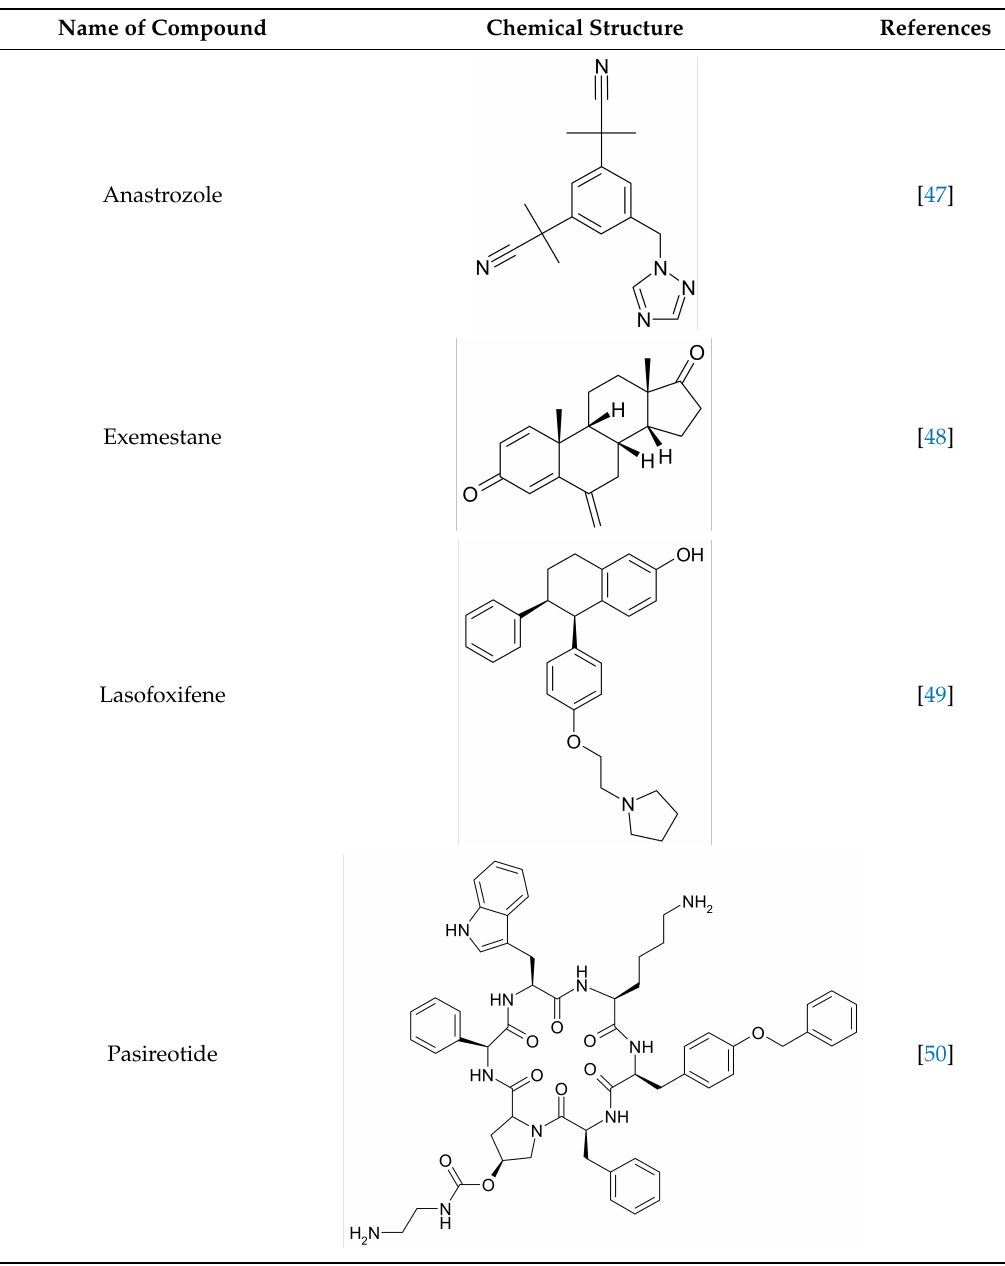
Table 1. Chemical structures of new compounds in breast cancer